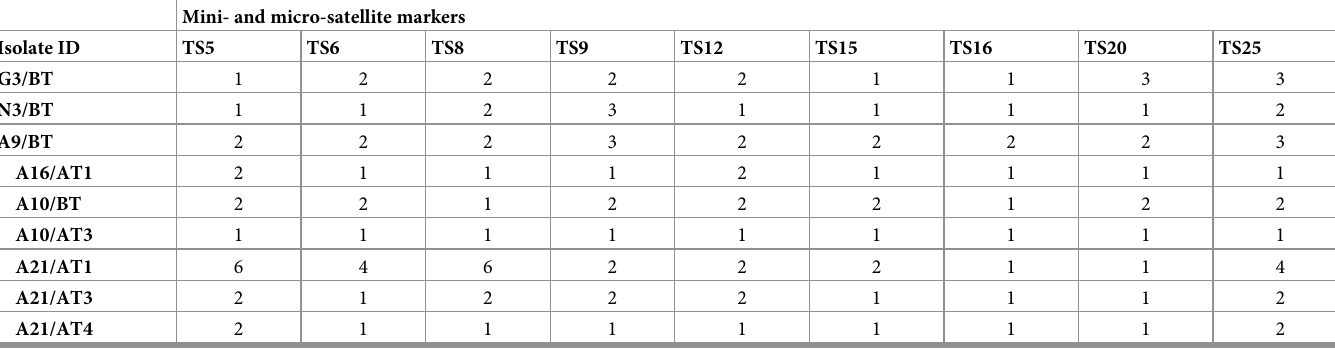
BT indicates T . annulata isolates prepared before drug treatment.